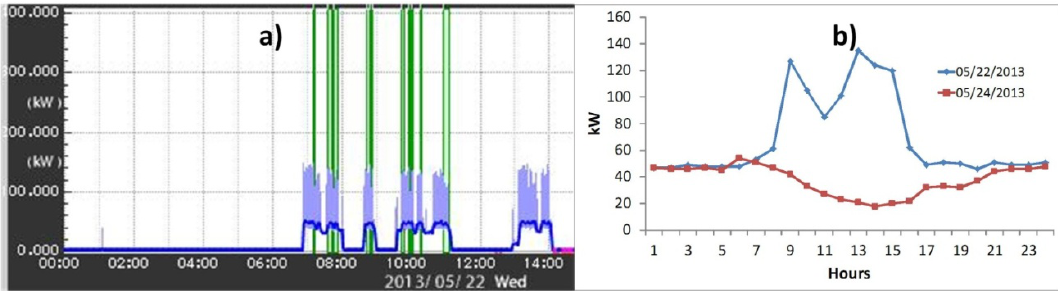
Figure 3. Load Curve (kW): ( a ) electrical consumption of pelletization mill on 05/22/2013; ( b ) total electricity consumption of the microgrid , blue curve day 05/22/2013 and red curve